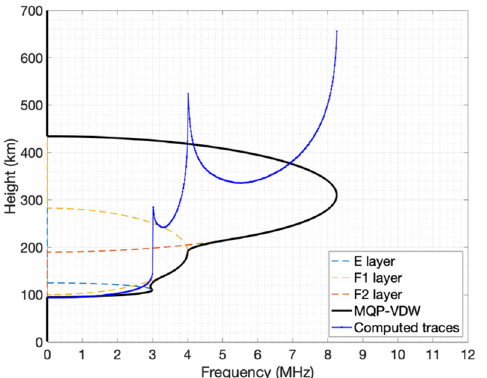
Figure 8. An example showing simulated electron density profiles with the MQP-VDW model and corresponding ionogram traces from the true height analysis. The dashed curves with different colors represent the electron density profiles of the respective ionospheric sublayers based on the QP model. The black curves show the simulated electron density profile from the MQP-VDW model with three QP layers and the valley within the E and F layer. The blue curves with dots are the computed traces of the modeled electron density profiles.